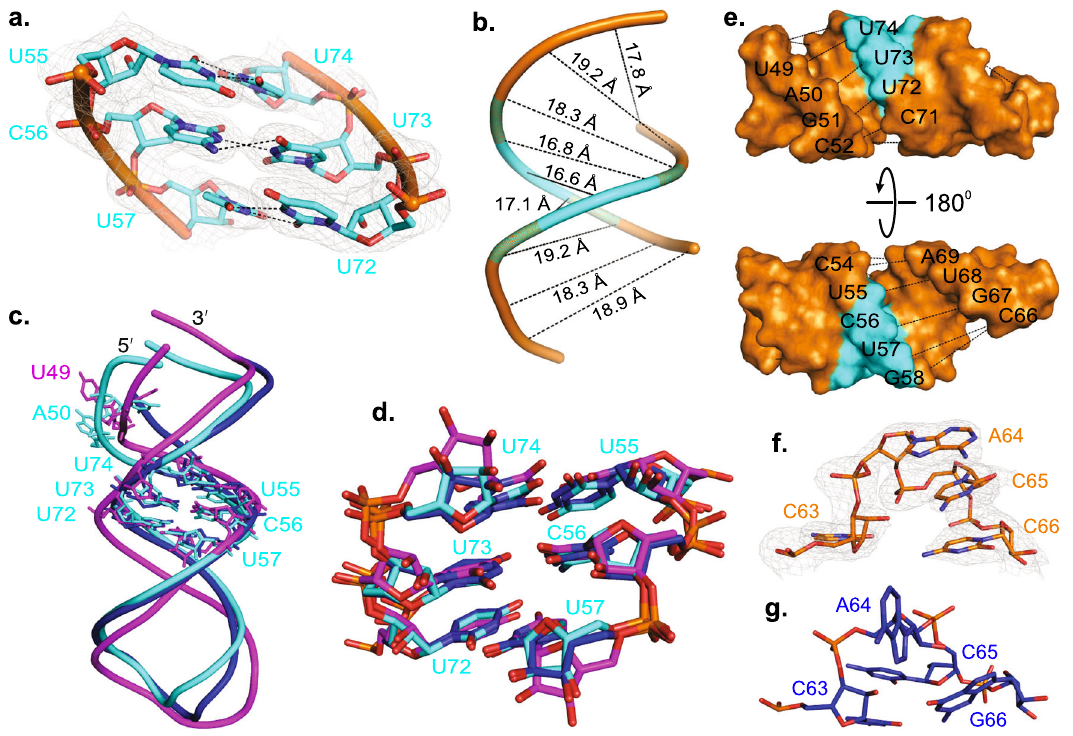
Fig. 3 | Comparison of the crystal and previous NMR structures of the 5 ′ CL sD subdomain. a The crystal structure of the Py-Py base-pairs within the P4 helix of CVB3 5 ′ CL2a. b The phosphate-to-phosphate distance between the base-pairs across the P4 helix. c Superposition of the CVB3 5 ′ CL2a subdomain sD crystal structure(cyan)withpreviouslyreportedNMRstructuresofthesDsubdomainsfor CVB3 5 ′ CL (blue) and an enteroviral consensus sequence (magenta). d SuperpositionofonlythePy-Pyregionforthethreestructuresasdescribedin( c ).